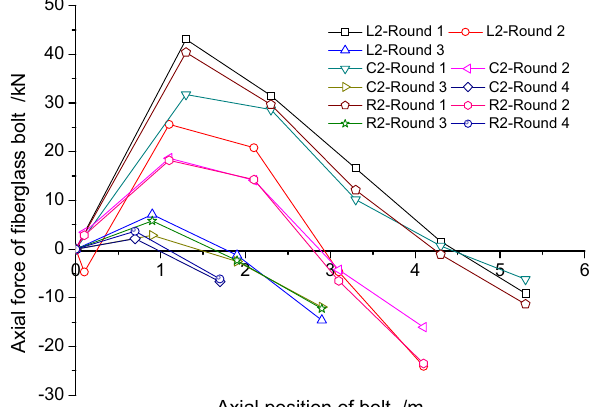
Figure 18. Axial force for L2, C2 and R2 bolts.